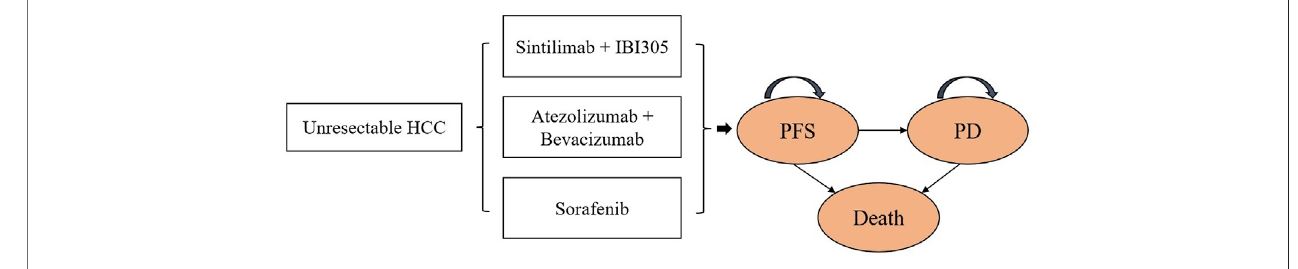
FIGURE 1 | Partitioned survival model. HCC, unresectable hepatocellular carcinoma; PFS, progression-free survival; PD, progressive